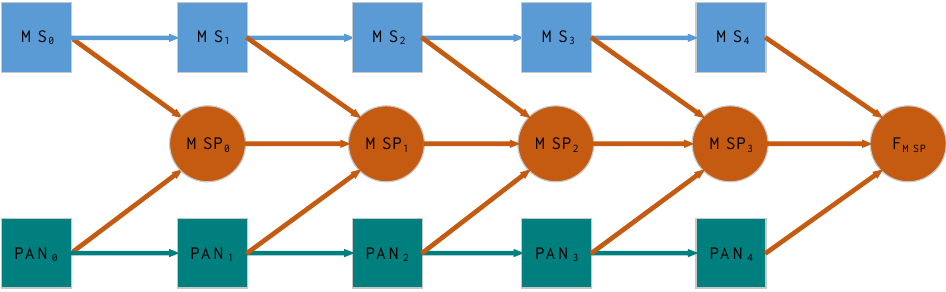
Figure 7. The overall framework for MS and PAN images